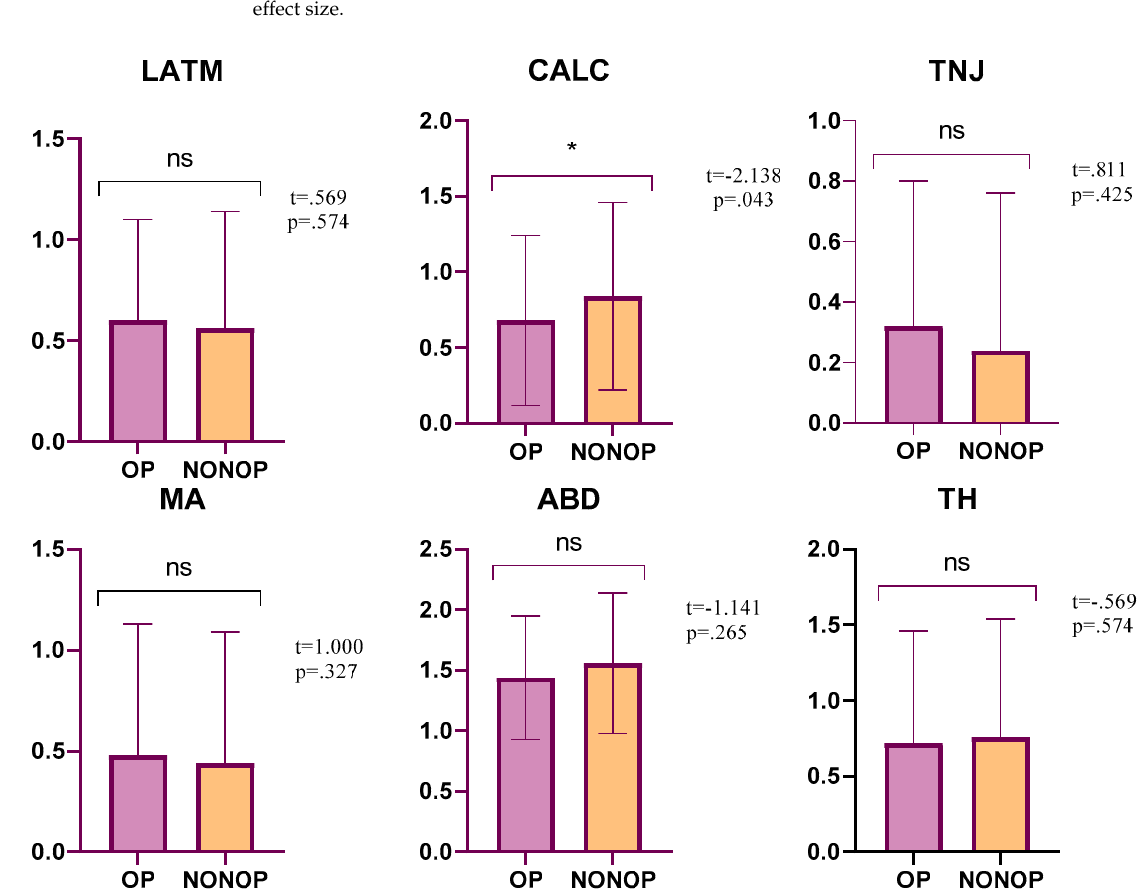
Figure 2. Comparison of TFPI scores of operated and non-operated sides. * p < 0.05. When the SLH (single leg hop) and triple hop distance test results of the operated and non-operated sides were evaluated, statistical significance was found for SLH ( p =